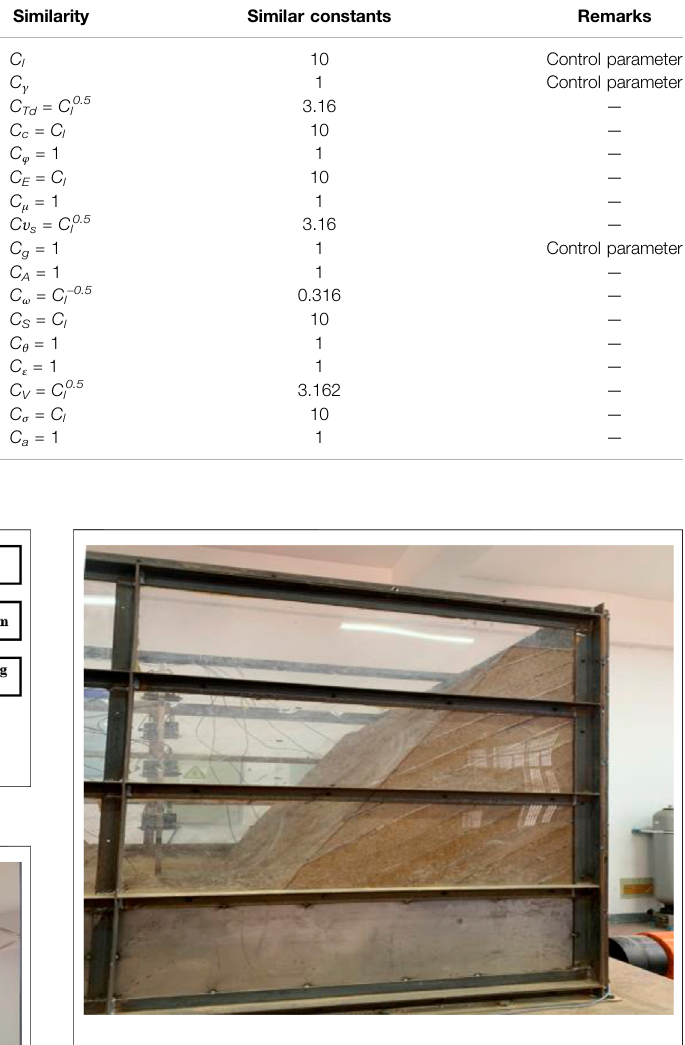
FIGURE 3 | The slope model in the